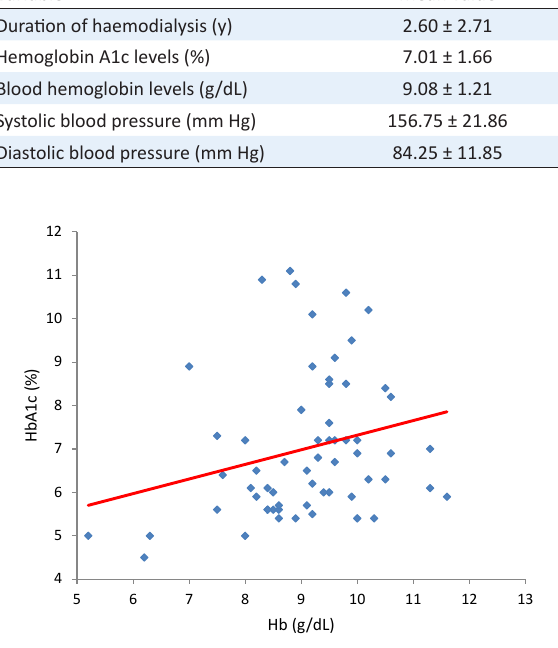
Figure 1 . Scatter plot showing relationship between HbA1c and blood haemoglobin values (r = 0.245, P = 0.05).